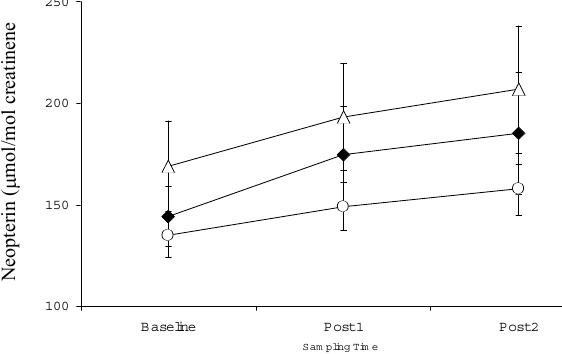
Figure 1. Mean neopterin levels of three anaesthetic groups. ∆ , Desflurane group; ♦ , Sevoflurane group; o , Isoflurane group. Baseline; post1 = 2 hours after the operation; post2 = 24 hours after the operation. The results are expressed as the mean ± standard error